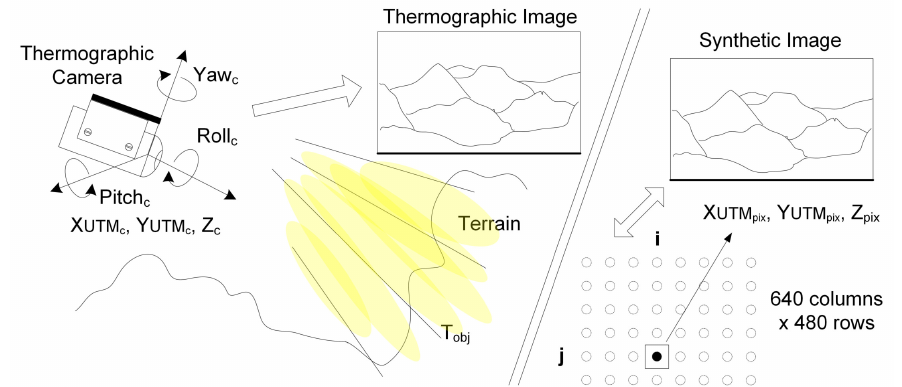
Figure 1. Synthetic image generation using ray-tracing techniques and optical equivalence with the thermographic